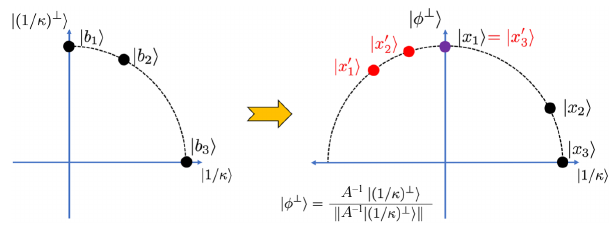
FIG. 3. Geometric representation of three pairs of instances used to prove Theorem 1, assuming that A has an eigenvalue 1 /κ